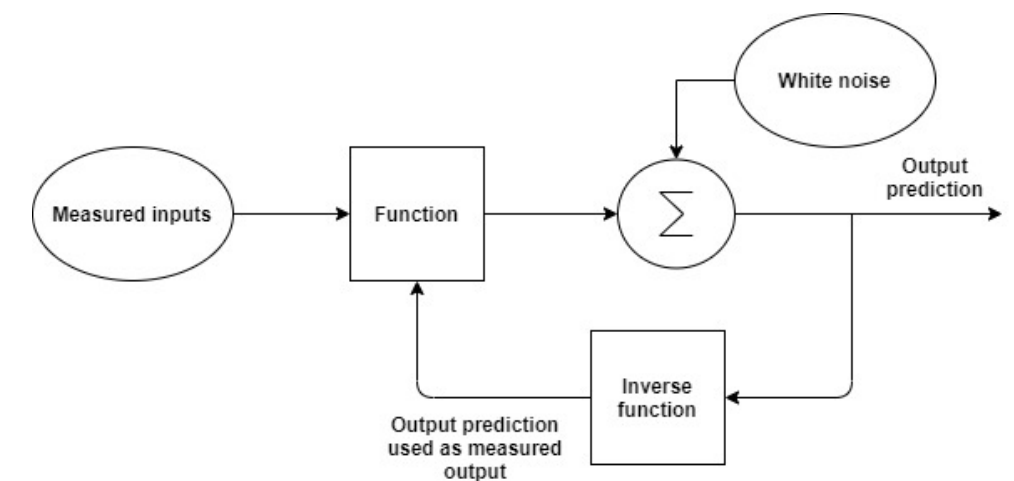
Figure 2. NARX structure used recursively.